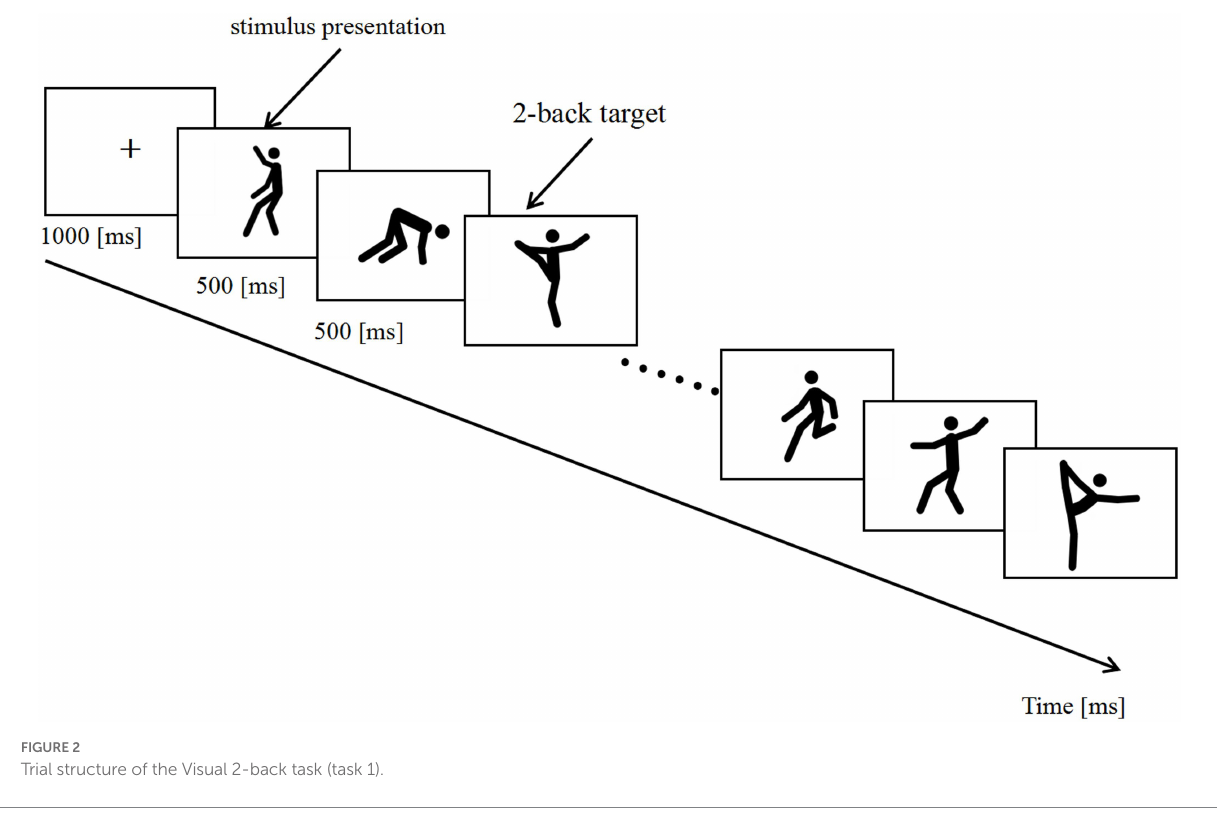
FIGURE 2 Trial structure of the Visual 2-back task (task 1).